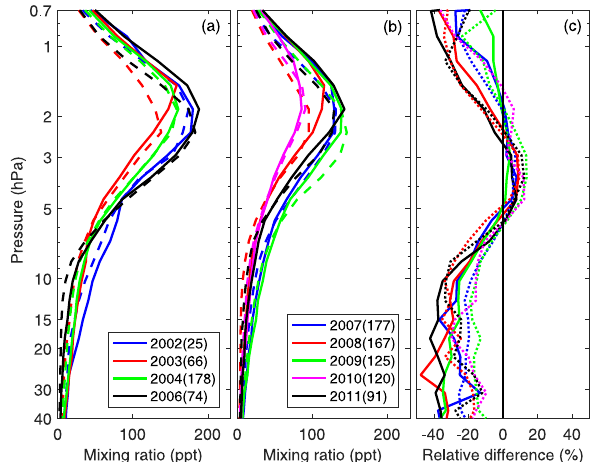
Figure 15. The relative NO 3 difference (WACCM– GOMOS)/median(GOMOS) (in %) during 2002–2011. Latitudes are from − 90 to 90 ◦ with 10 ◦ resolution. A cross marks a point where the difference does not deviate from zero in a statistically significant way. A cell with a dot marks a point where there are no collocated